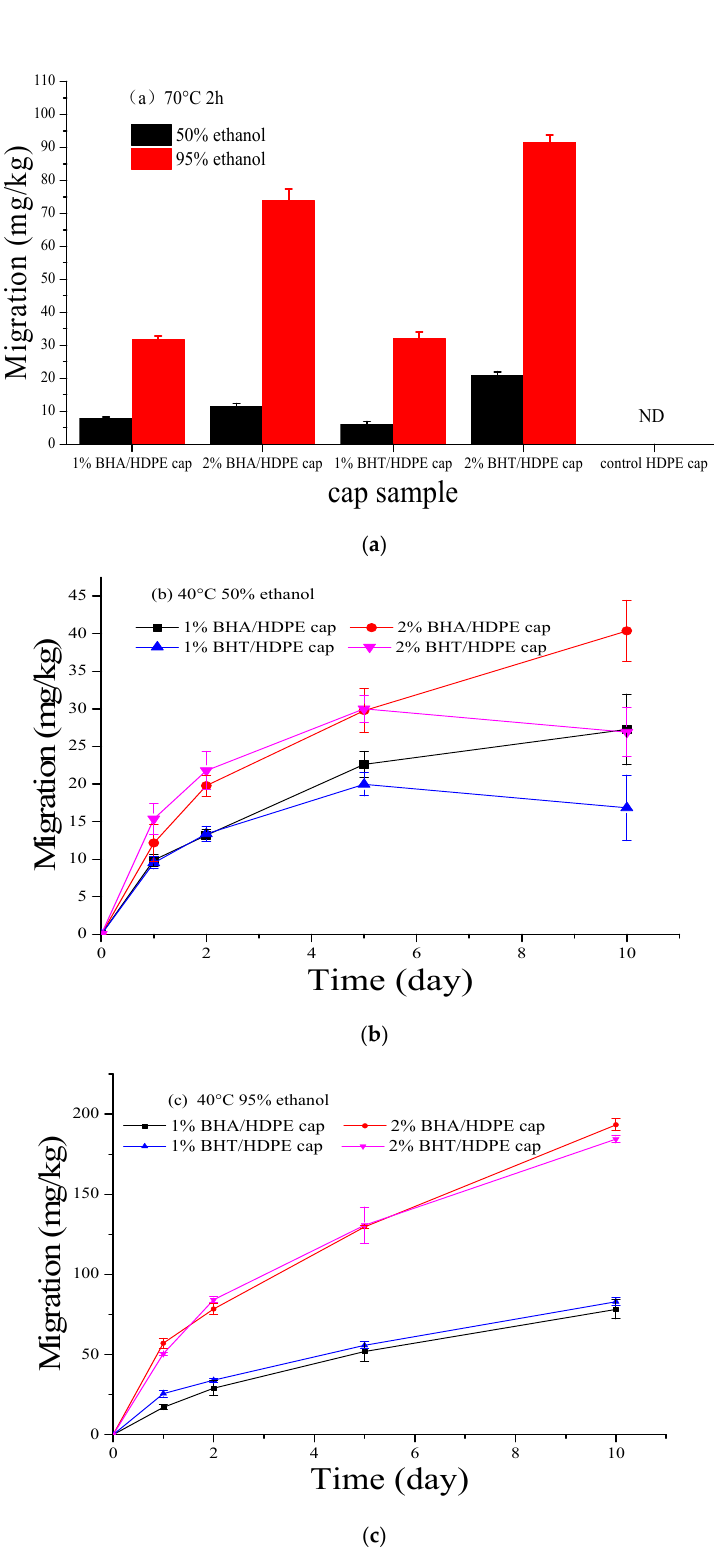
Figure 6. Migration of BHA and BHT from antioxidant active plastic bottle cap into food simulants under the multiple-use condition ( n = 3), ( a ) in 50% and 95% ethanol at 70 ◦ C, ( b ) in 50% ethanol at 70 ◦ C and ( c ) in 95% ethanol at 70 ◦ C. The migration potentials of BHA and BHT in 50% and 95% ethanol at 70 ◦ C are presented in Figure 6a. A 50% ethanol concentration is recommended by the European commission for simulating several dairy products. The migration rates of BHA and